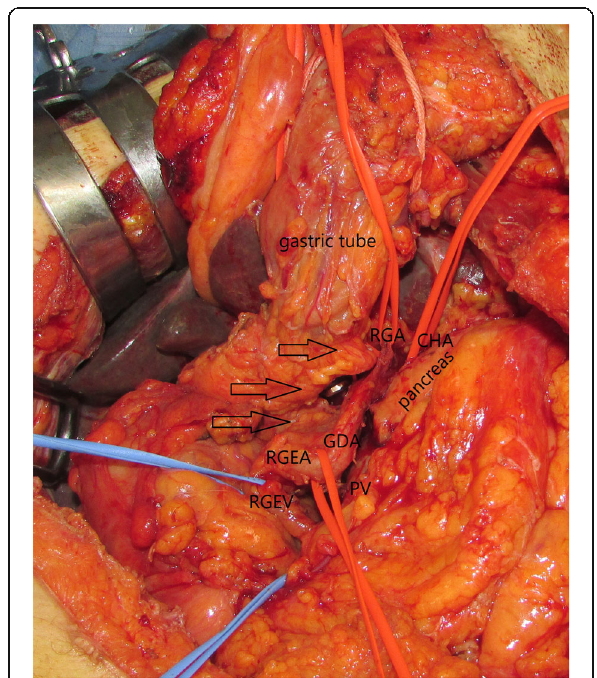
Fig. 5 Surgical view following pancreaticoduodenectomy. The image following tumor resection is shown. Arrows indicate the RGEA/V